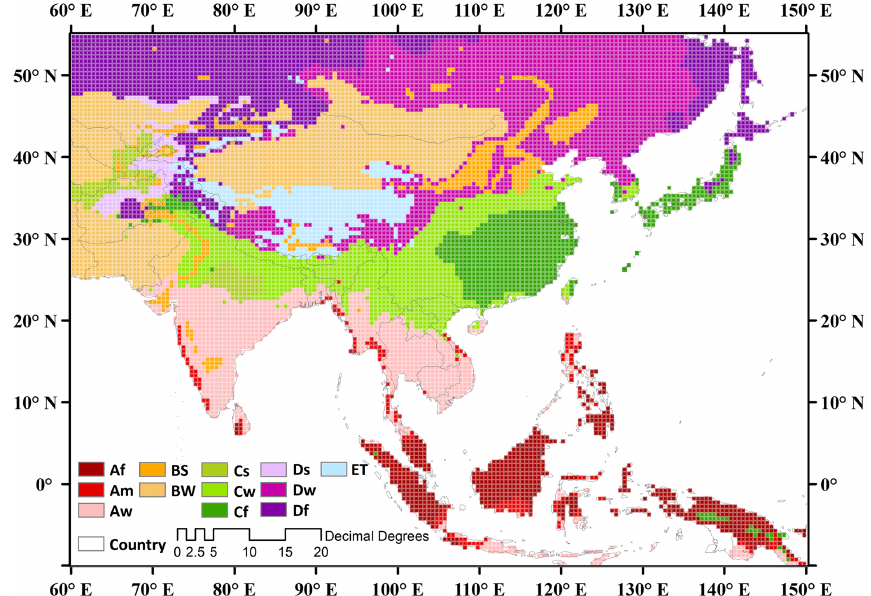
Figure 1. Study domain, climate zone classifications, and the 10977 grid points of the VIC model used for the analyses in this study. National boundaries are delineated by black lines. The 12 climate zones are based on the Köppen climate zone method and are denoted by individual